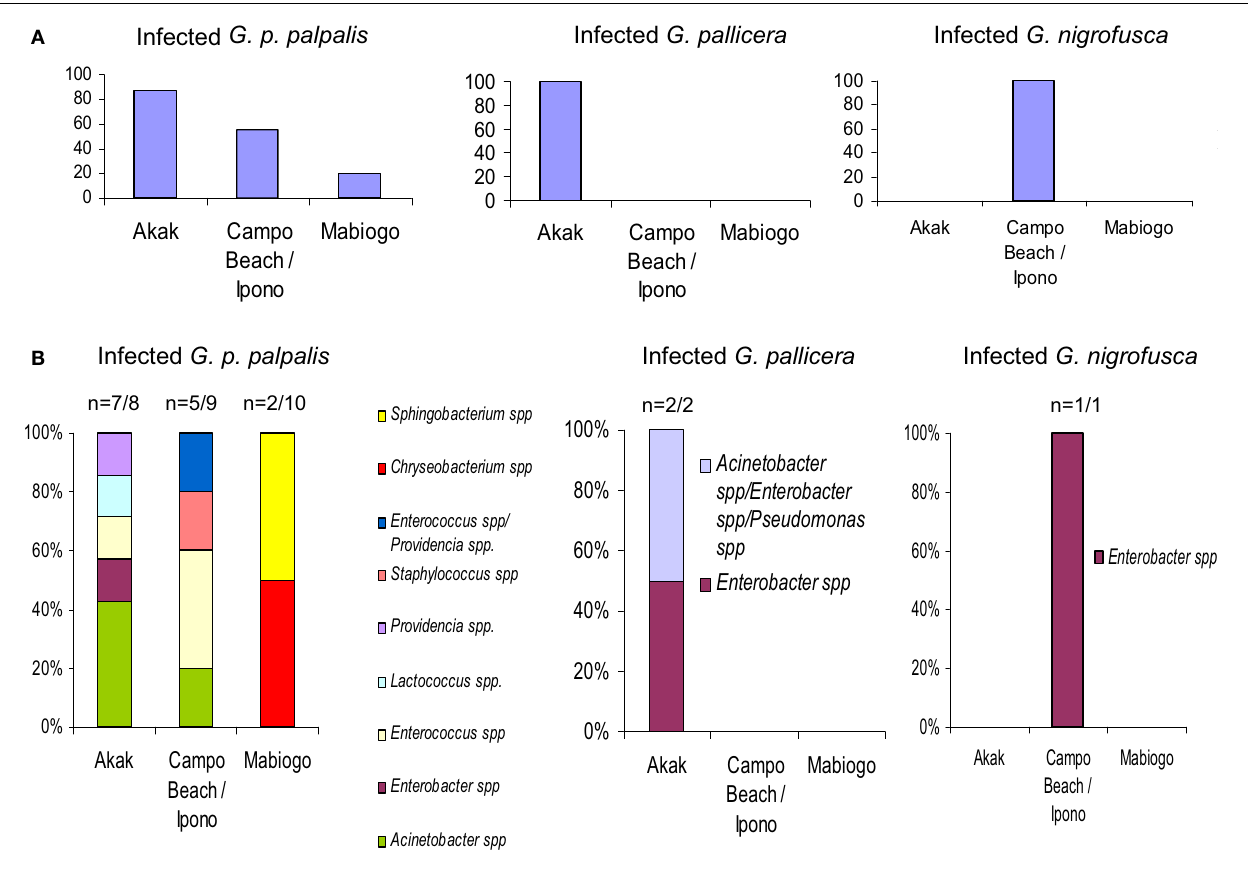
FIGURE 3 | G. palpalis palpalis , G. pallicera and G. nigrofusca fly’ bacterial infections occurring in the different villages (Akak, Campo Beach/Ipono and Mabiogo) of the Campo focus in Cameroon, according to Geiger et al. (2011). (A) Prevalence of bacterial infection in the different